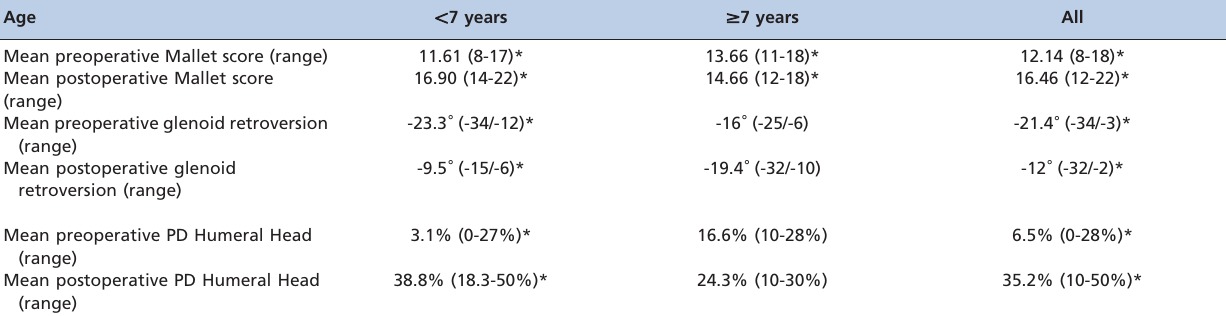
Table 2 - Mean pre- and postoperative Mallet scores, degrees of glenoid retroversion, and percentages of posterior deviation of the humeral head (PD).